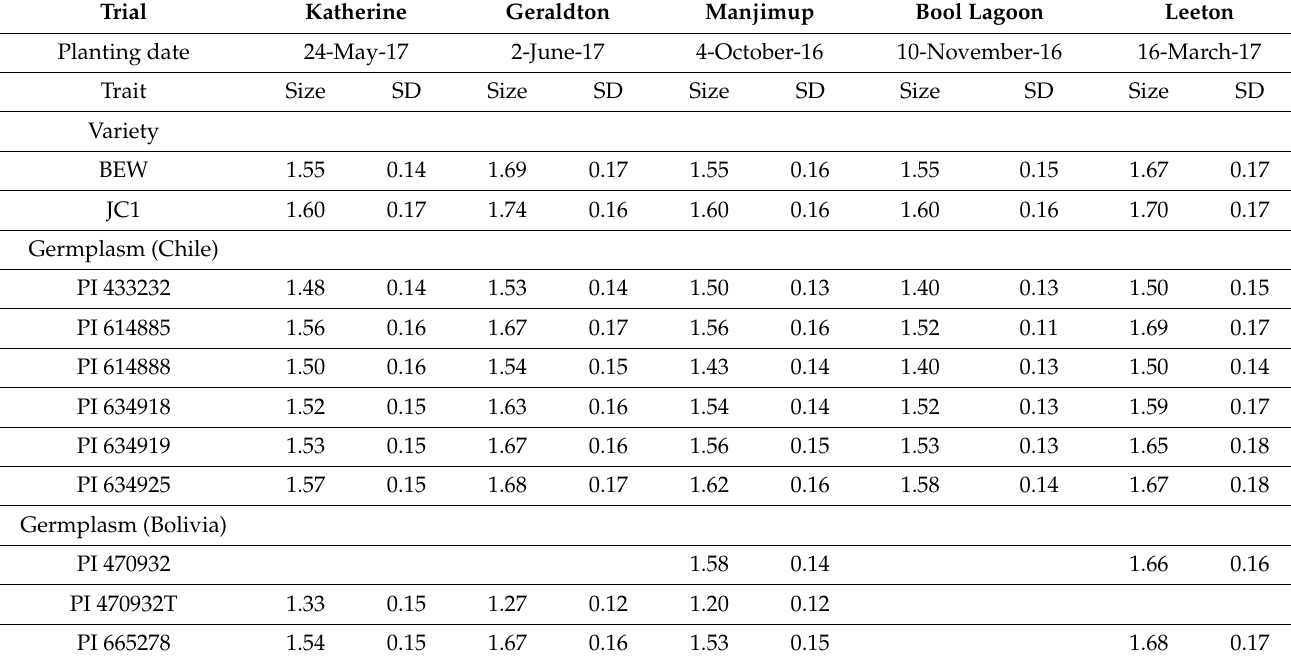
Table 13. Estimated mean weighted seed size-width (mm) and standard deviation (SD) of the discrete distribution at selected trial sites. LSD ( p = 0.05) is 0.064 for Size; LSD ( p = 0.05) is 0.020 for